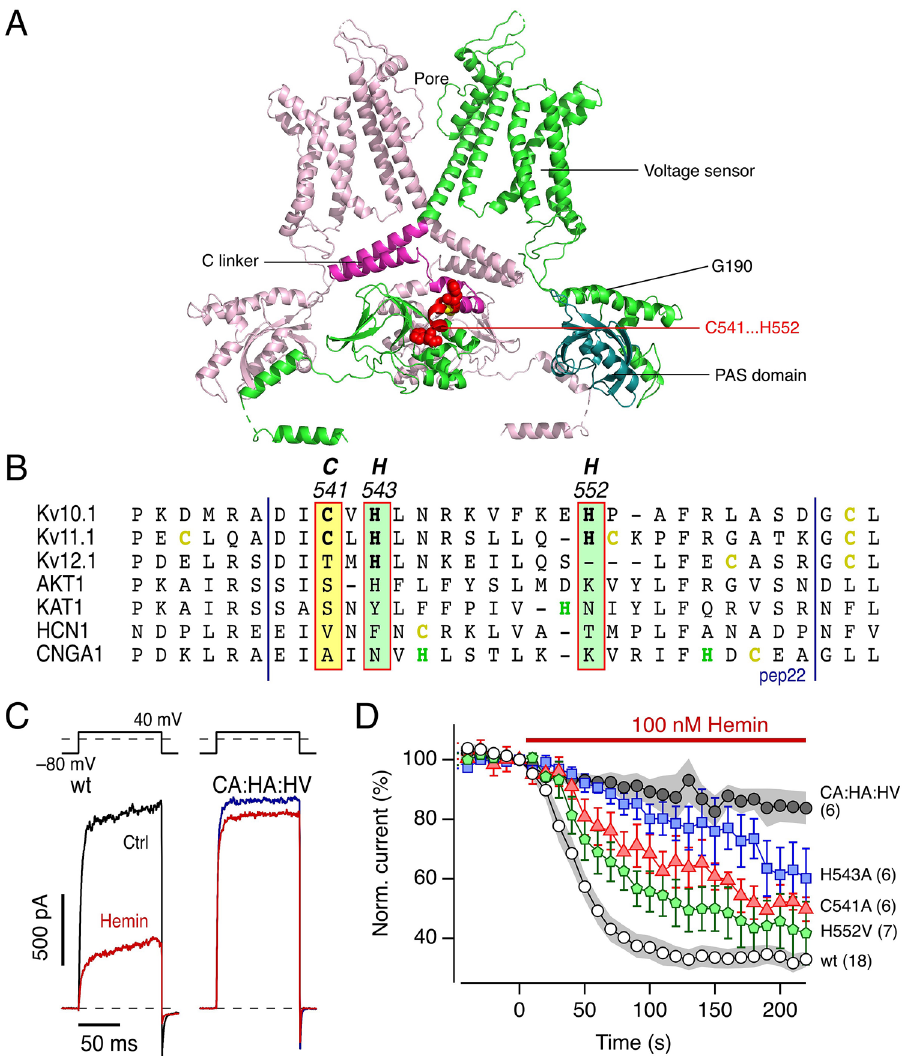
Figure 4. Involvement of the C-linker motif CxHx 8 H for the impact of hemin on Kv10.1. ( A ) Two opposing subunits of rat Kv10.1 (5K7L) 53 indicating for one subunit (green) the transmembrane segments with the voltage sensor, the N-terminal PAS domain (cyan) and the deletion site G190 to yield Δ2-190, as well as the C-terminal C linker (magenta) which ends in the identified hemin-binding motif encompassing C541..H552 (red). For clarity, the other two subunits in the view direction as well as the calmodulin molecules present in 5K7L are not shown. ( B ) Multiple sequence alignment of the C-linker region of the CNBD family of channels shows that the heme-binding motif (CxHx 8 H) is conserved in some members of the EAG family (Kv10.1, Kv11.1), while absent in ELK1 (Kv12.1), in the plant K + channels AKT1 and KAT1, and the cyclic nucleotide-gated channels HCN1 and CNGA2. The putative heme-binding motif is highlighted. The vertical blue lines mark the peptide sequence used for the synthesis of 22-mer peptides. ( C ) Representative inside-out current traces from Xenopus oocyte membrane patches at 40 mV before (black, blue) and after hemin application (100 nM in 1 mM reduced GSH, red) for Kv10.1 wild type (wt) and variant C541A:H543A:H552V (CA:HA:HV). ( D ) Time course of current reduction upon application of 100 nM hemin in reduced GSH for the indicated channel types. Data are mean ± sem with n in parentheses (for wt and CA:HA:HV sem in shading). Straight lines connect data points for